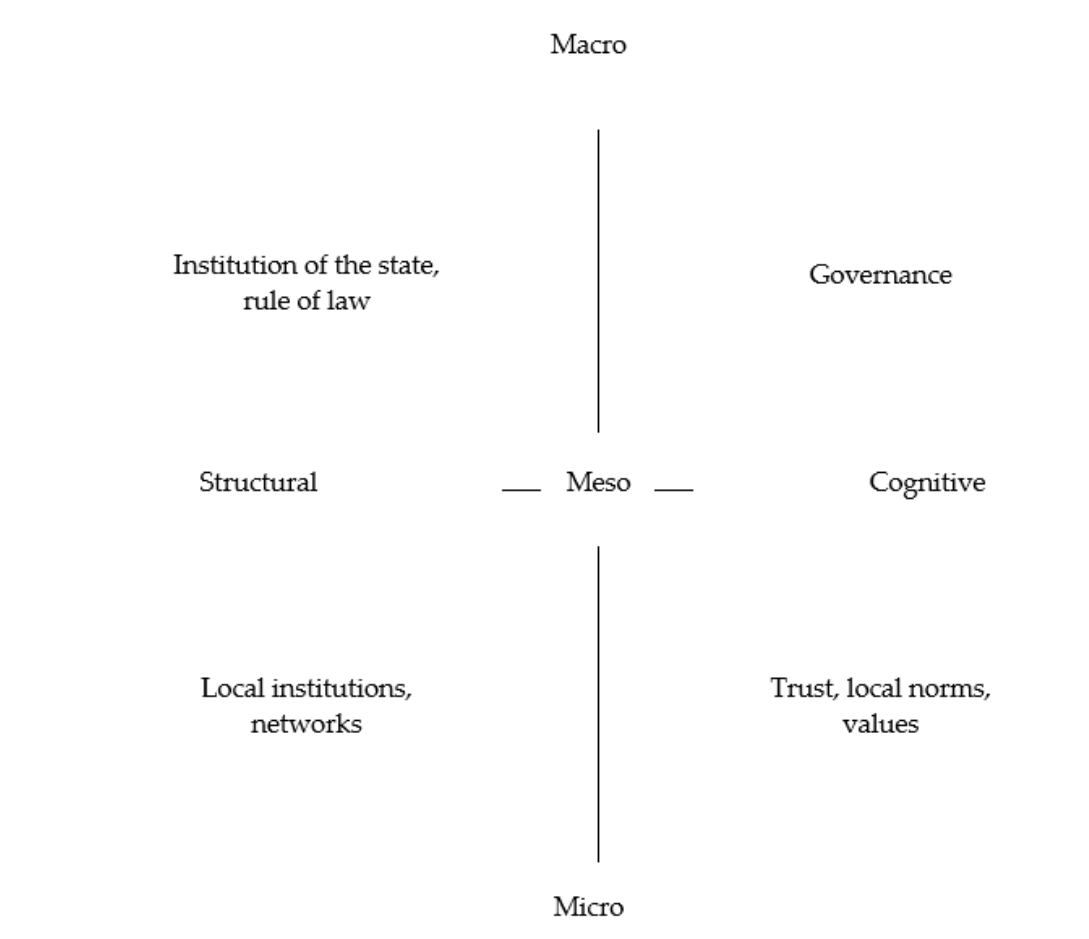
Figure 1. The Forms and Scope of Social Capital [35].